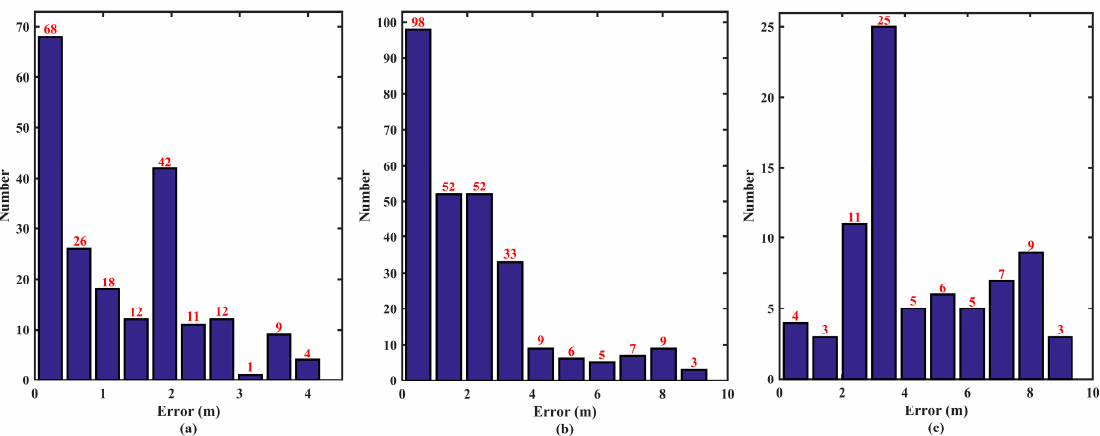
Figure 13. Histogram of WiFi-Chain-WiFi, All-WiFi, and No-WiFi-Chain-WiFi. ( a ) WiFi-Chain-WiFi; ( b ) All-WiFi; ( c ) No-WiFi-Chain-WiFi.